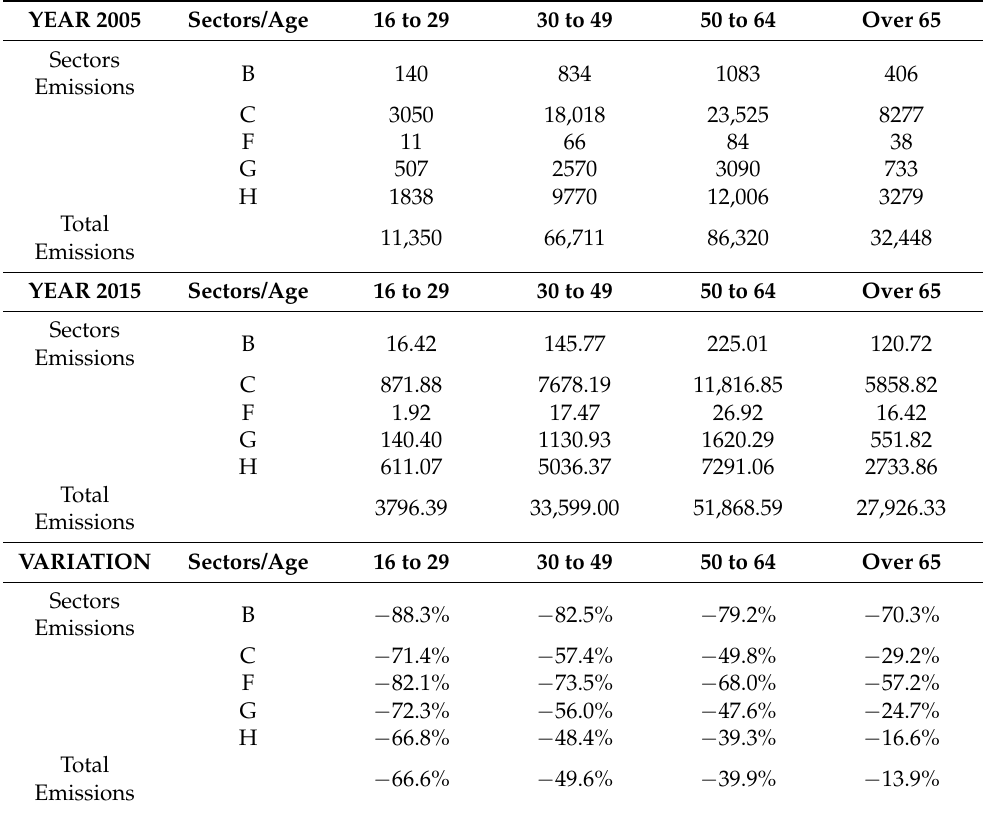
Table 4. CO 2 emissions linked to household consumption by age group (thousands of tons of CO 2 equivalent) and variations